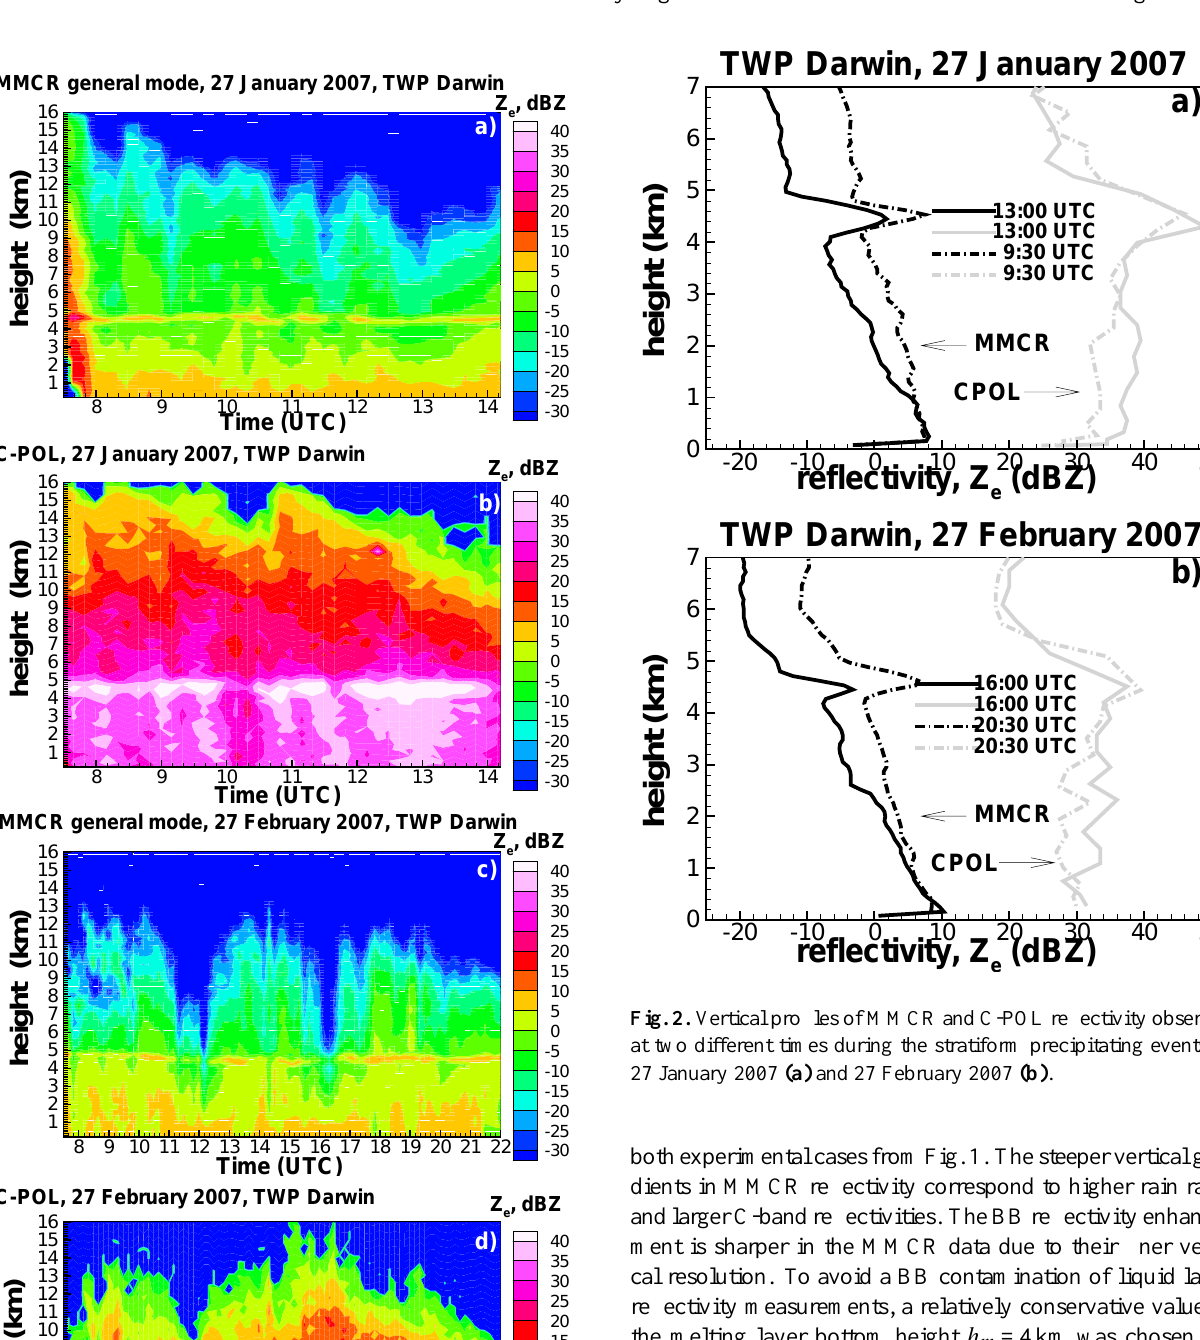
both experimental cases from Fig. 1. The steeper vertical gra- dients in MMCR reflectivity correspond to higher rain rates and larger C-band reflectivities. The BB reflectivity enhance- ment is sharper in the MMCR data due to their finer verti- cal resolution. To avoid a BB contamination of liquid layer reflectivity measurements, a relatively conservative value of the melting layer bottom height h m = 4 km was chosen for retrievals. A value of 0.3 km was chosen for h 0 because examining the data indicates that at lower heights, MMCR measurements are sometimes saturated and C-POL measure- ments might have some beam blockage problems. The sig- nificant difference in MMCR and C-POL reflectivities at the lowest “good” gate (i.e., at the h 0 height), where attenuation due to hydrometeors is expected to be very small, can be ex- plained by the attenuation caused by the wet MMCR radome. This fact does not cause problems, because the MMCR re- flectivity differences and not their absolute values are used for